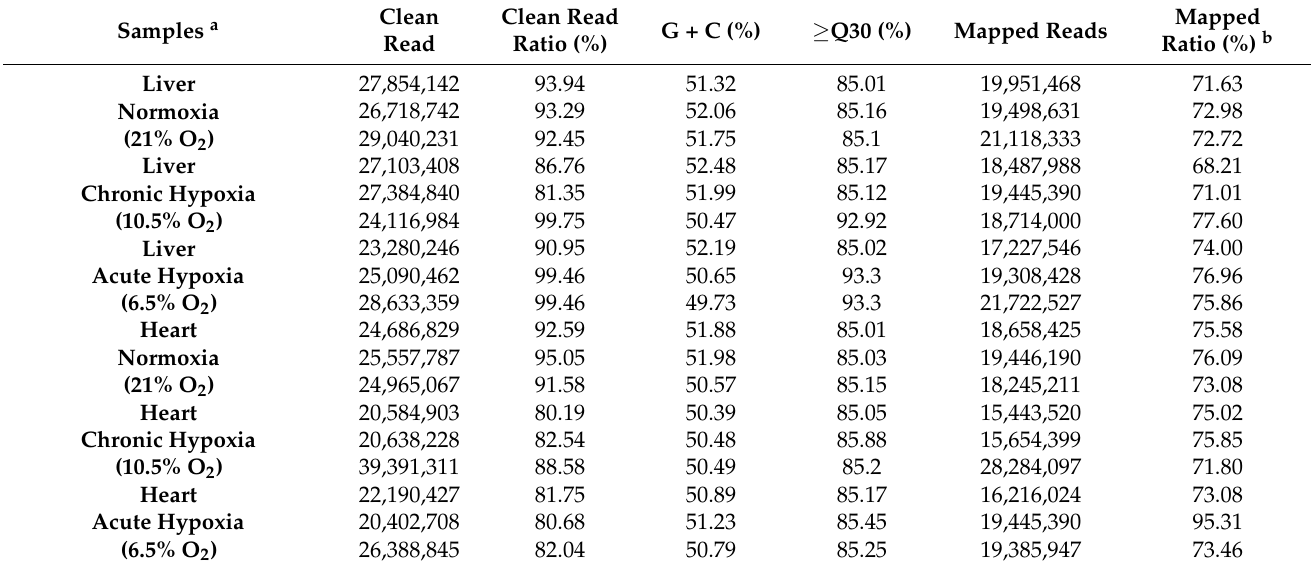
Table 1. Mapping Statistics of Clean Reads with Assembled